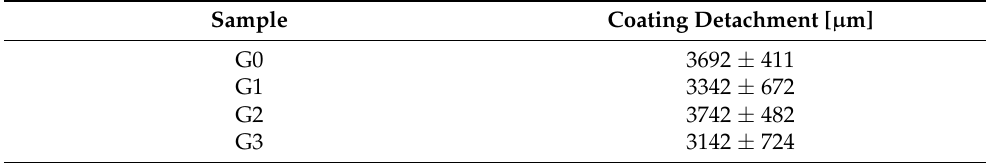
Table 3. Coatings detachment distance [ µ